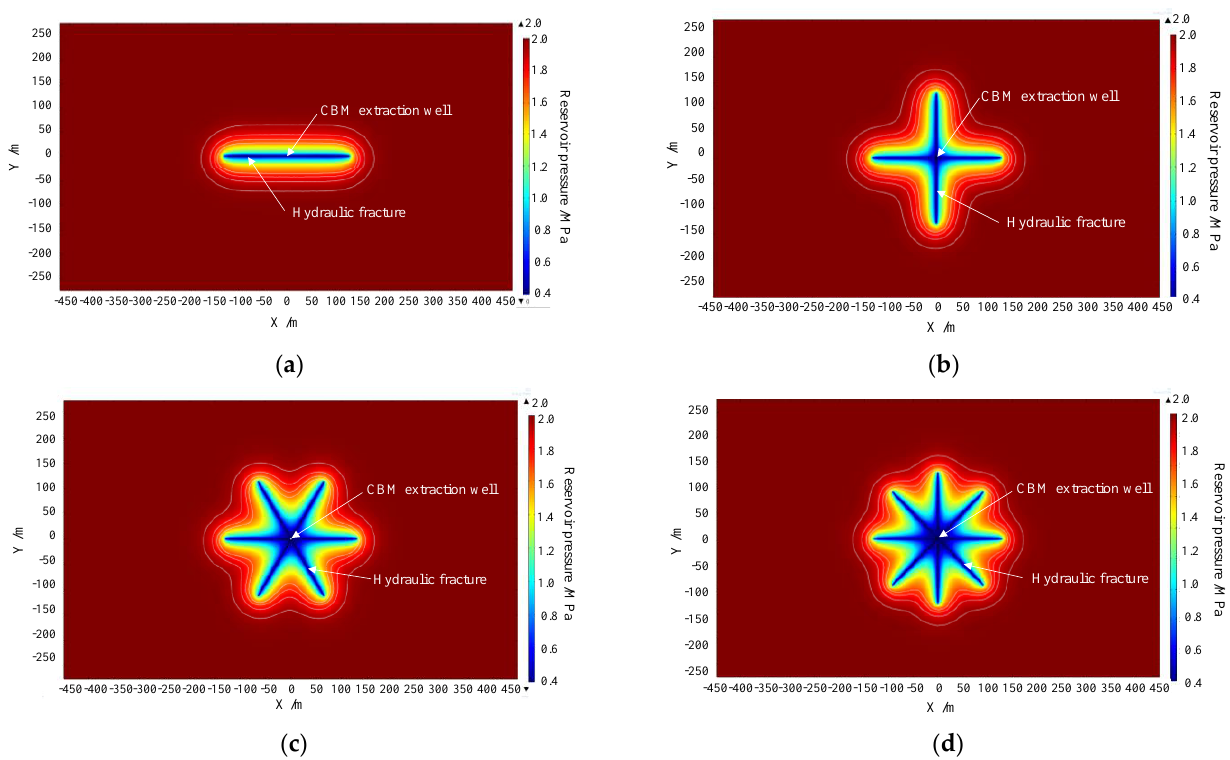
Figure 15. Reservoir pressure distribution with different hydraulic fracture morphologies after CBM is extracted after one month. ( a ) a single hydraulic fracture, ( b ) two hydraulic fractures, ( c ) three hydraulic fractures and ( d ) four hydraulic fractures.